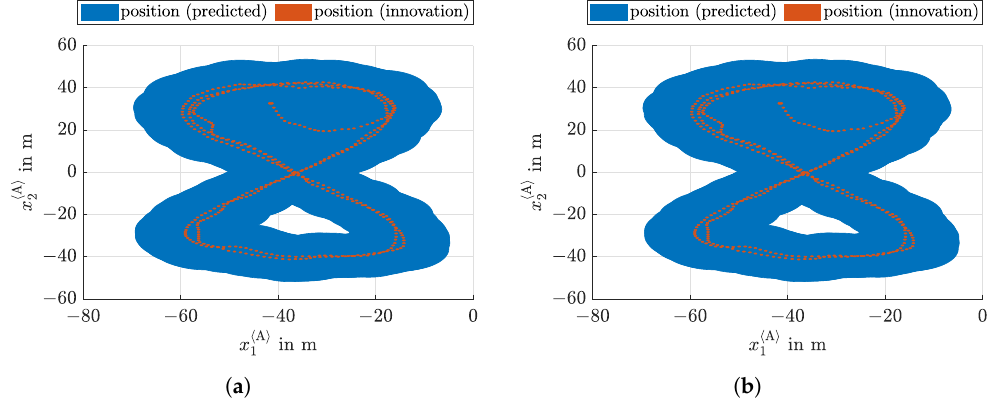
Figure 7. Localization of the DDboat A without heading measurement. ( a ) Pure position measure- ment. ( b ) Position and velocity